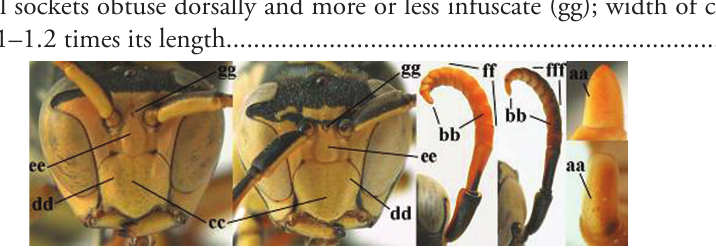
26 Mesosternum entirely black (a); black baso-dorsal stripe on third antennal seg- ment 0.25 times length of segment (b); lateral ridges of clypeus and ridge between antennal socket and clypeus more distinct (c); [largely yellow coloured species, specimens from eastern Turkey however may have reduced whitish yellow mark- ings; W and C Asia, Cyprus, Egypt, Crete. ......... P. bucharensis Erichson, 1849